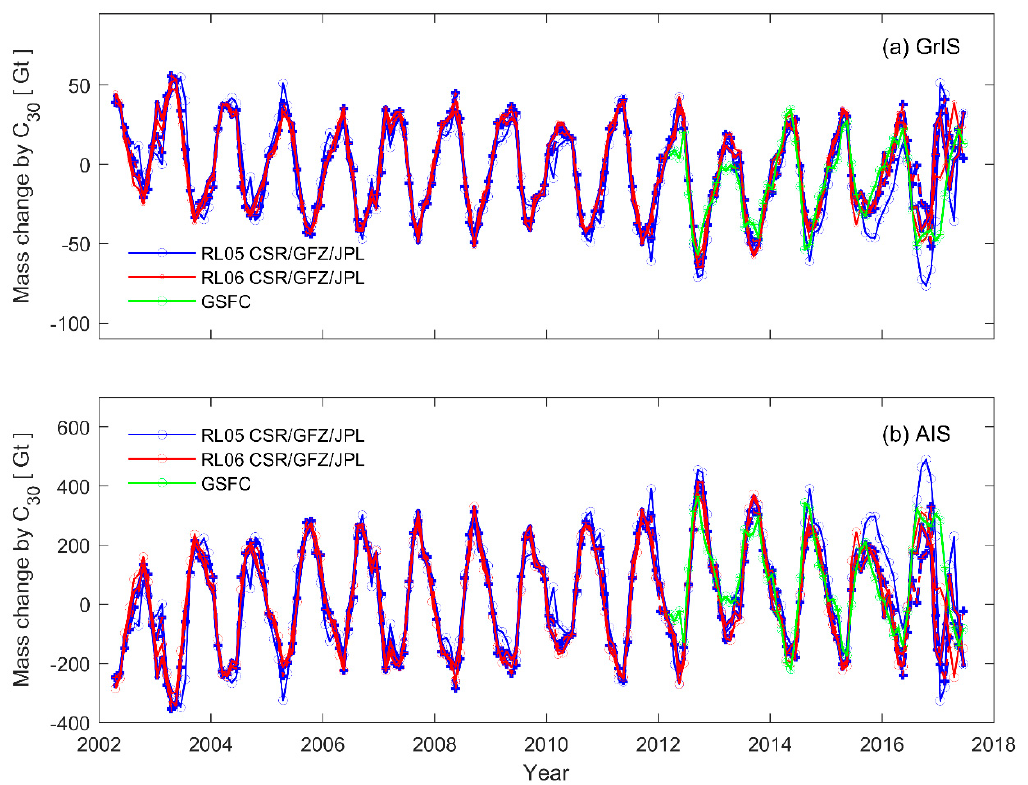
Figure 4. Mass change time series caused by C 30 from CSR / GFZ / JPL-published GRACE RL05 and RL06 data and by SLR-based C 30 in TN14 from GSFC over ( a ) the GrIS and ( b ) the AIS during the GRACE mission span. CSR / GFZ / JPL means that time series of mass change caused by C 30 are separately calculated and shown for GRACE data published by CSR, GFZ, and JPL. Table 4. The trends of mass change time series caused by estimates separately from GRACE RL05/RL06 data and GSFC over the GrIS and the AIS during the period from August 2002 to February 2012, and the period from March 2012 to July 2016. RL05 RL06 Trend [ ] Trend [ ] Mass change GRACE GRACE GSFC caused by 2002.08– 2012.03– 2016.07 2012.02